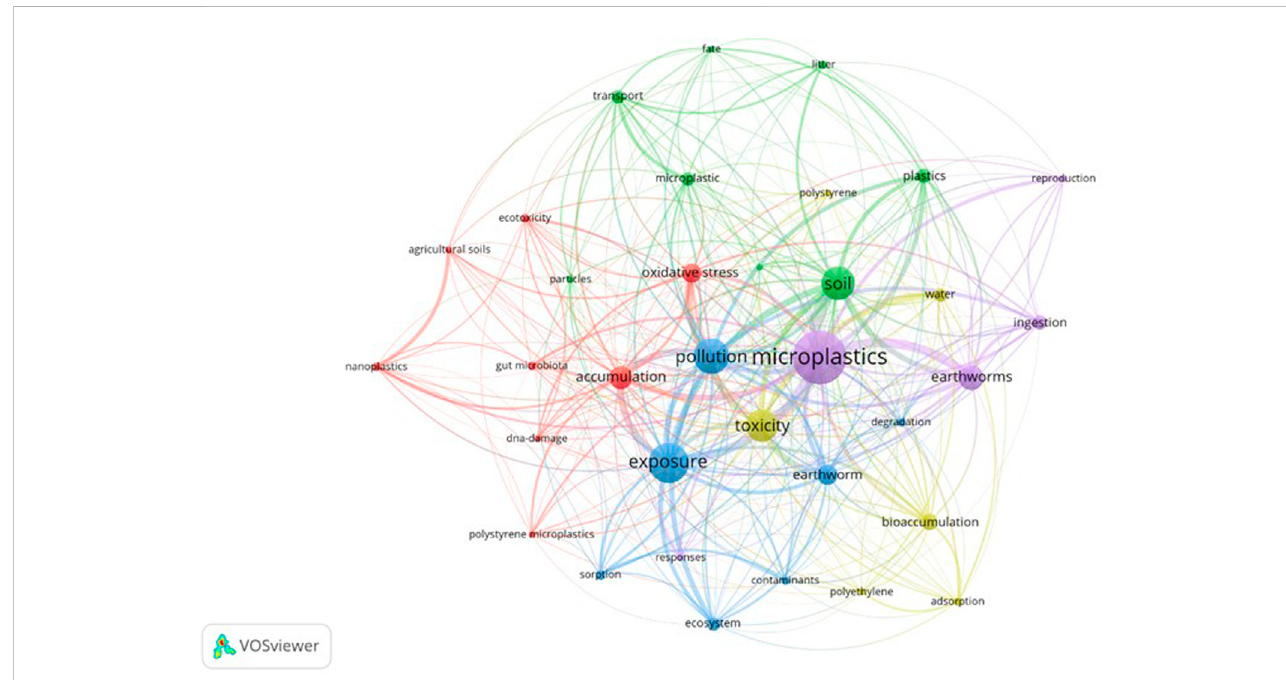
FIGURE 2 Keywordco-occurrencemapofstudiespublisheduntilDecember2021focusingontheinteractionsbetweenmicroplasticsandearthworms.Thesizeof the nodes indicates the frequency of occurrence, and the thickness of the lines between the nodes indicates the strength of the